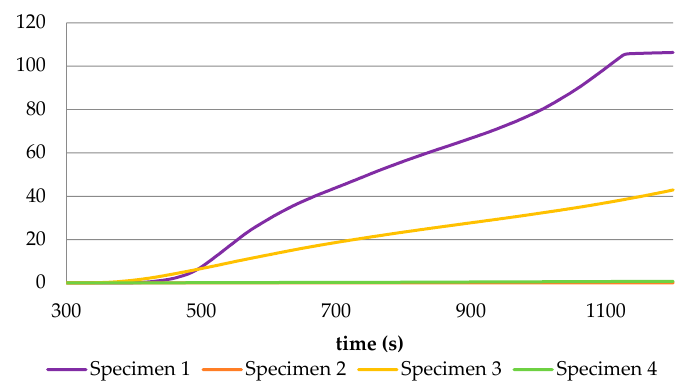
Figure 6. Total heat release ( THR 600s ) results as a function of time of the test.